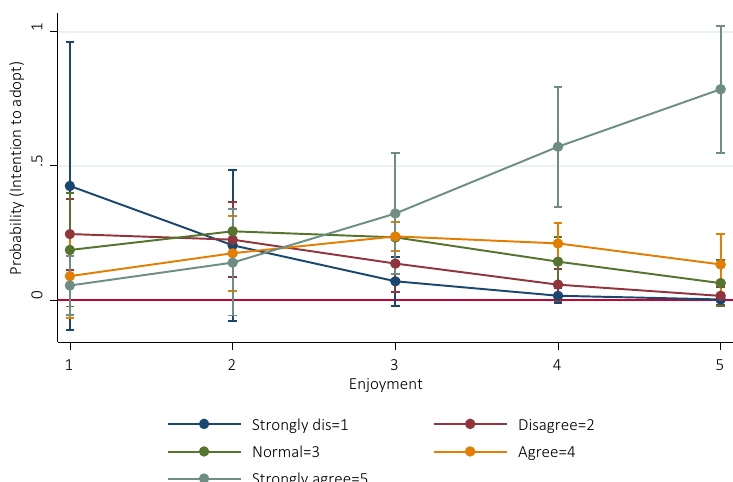
Figure 4. Marginal effects of interaction between time preference and enjoyment on the probability of intention to join the gig economy (in the